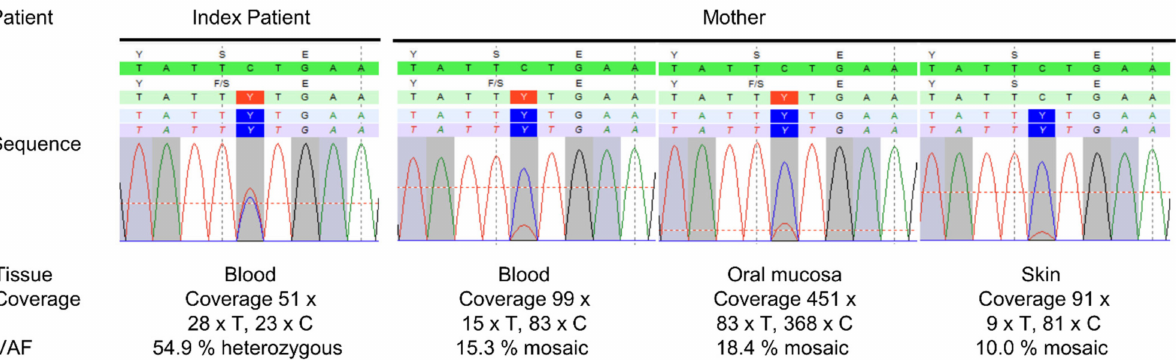
Figure 2. Next generation sequencing results. The variant NM_015560.3:c.806C>T, p.(Ser269Phe) in exon 8 of the OPA1 gene was detected in a heterozygous state in DNA isolated from peripheral blood of the index patient (VAF = 54.9%). In the mother, the variant was detected with a mosaic of 15.3% in peripheral blood, 18.4% in oral mucosa and 10.0% in skin. VAF = variant allele